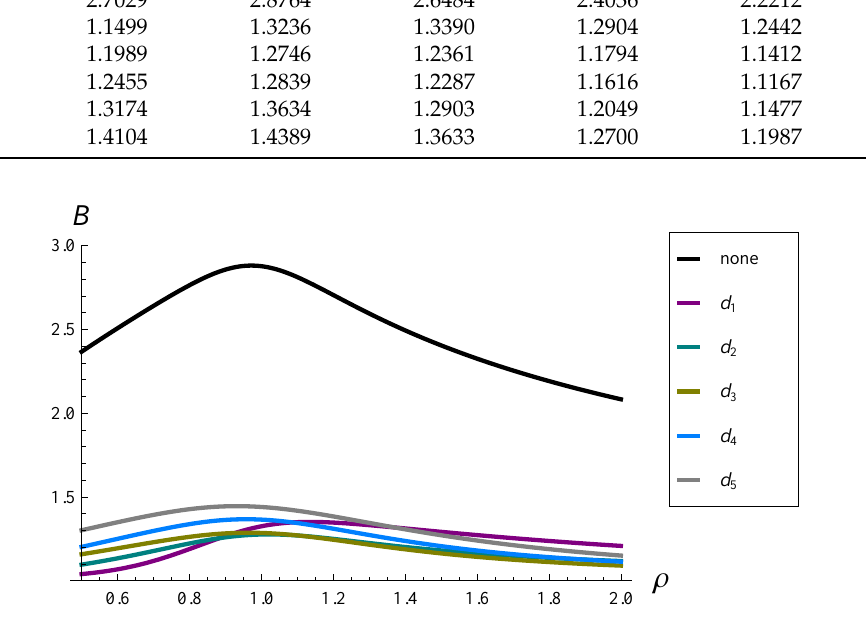
Figure 4. Burst ratio versus the system load for dropping functions d 1 – d 5 and no dropping function.